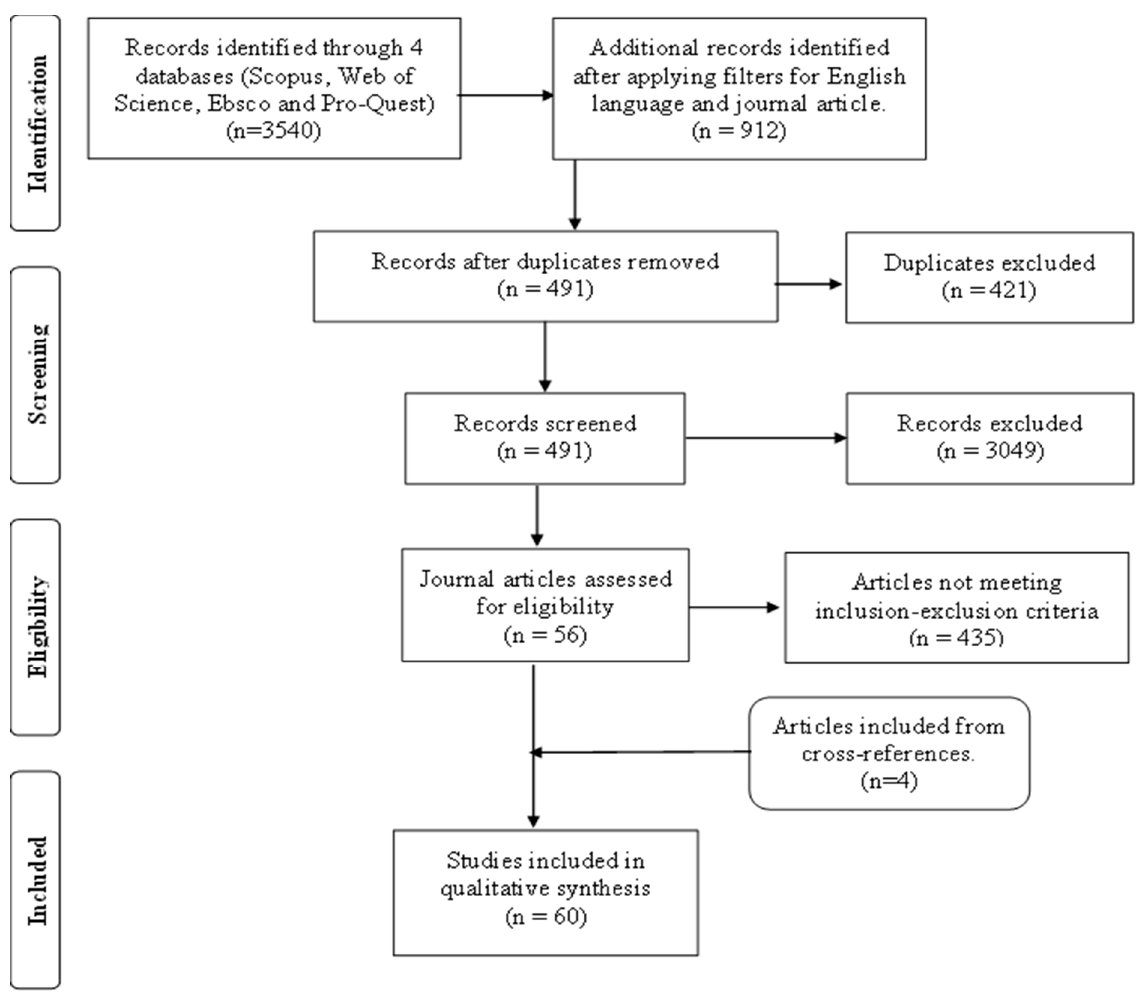
Figure 4. PRISMA approach to review.